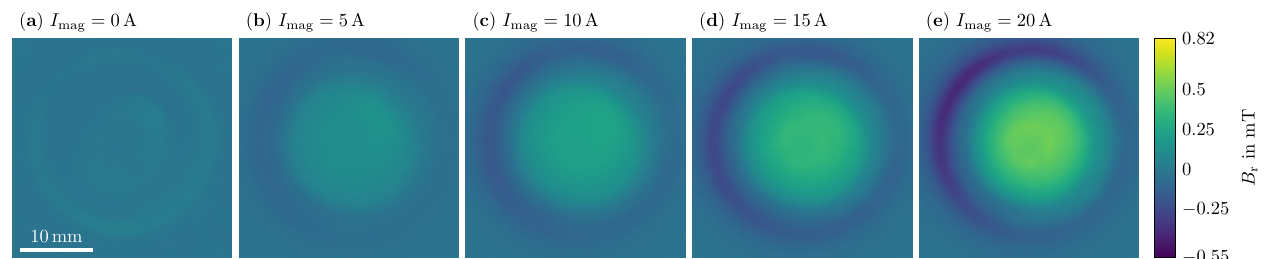
Figure 15. Two dimensional (2D)-surface scans of the residual magnetic flux density of sample 05 of MAT1 with increasing coil currents I mag in A1-configuration.